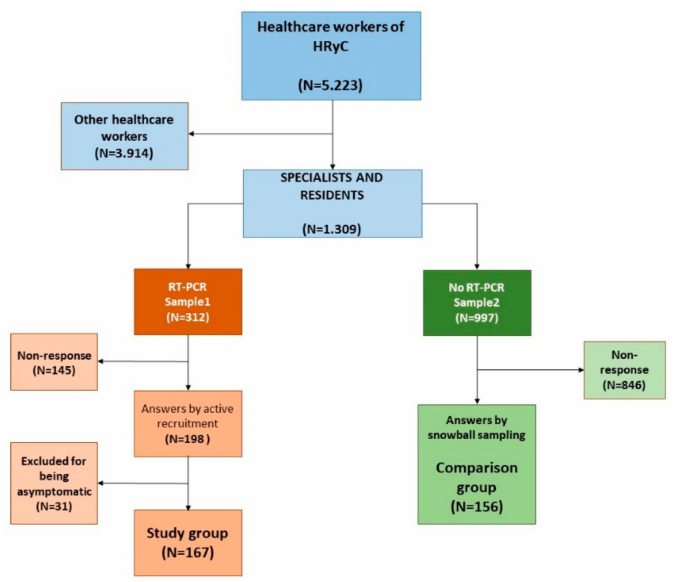
Figure 2. Sample